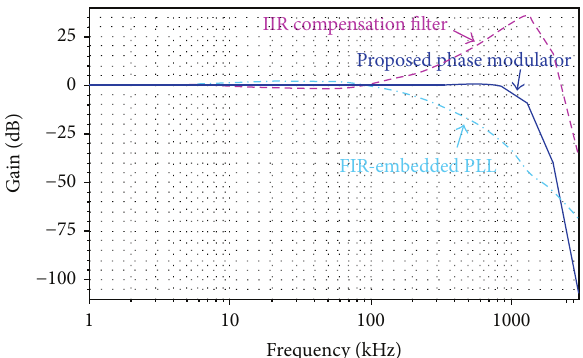
Figure 7: Simulated frequency response of presented phase modu-